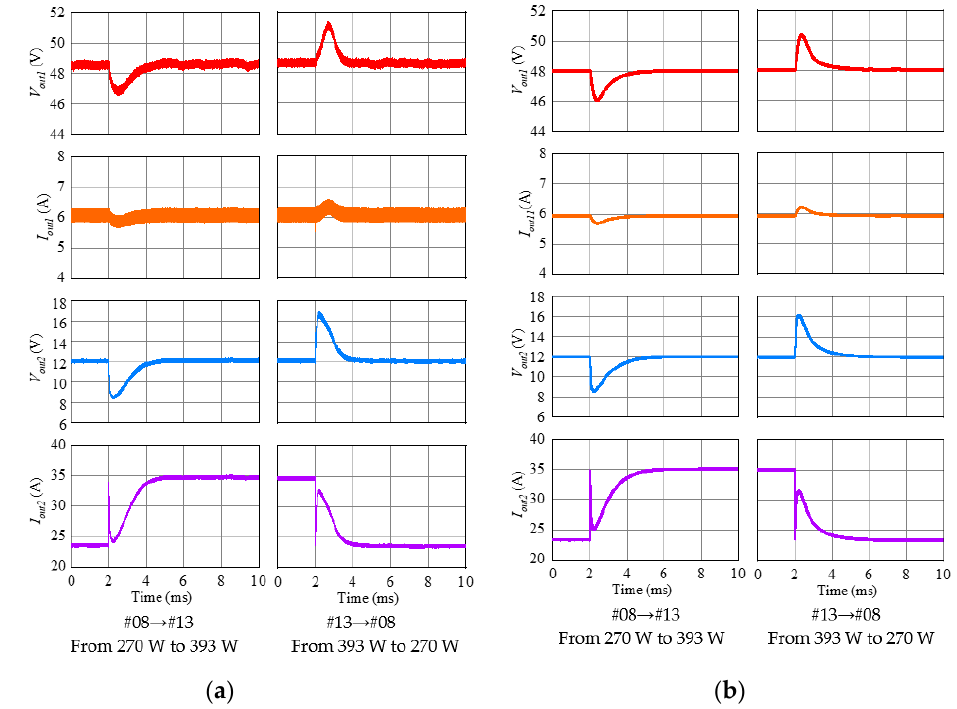
Figure 18. Results of P out 2 dynamic response test when P out 1 = 286 W: ( a ) Experimental results; ( b ) Simulation results.